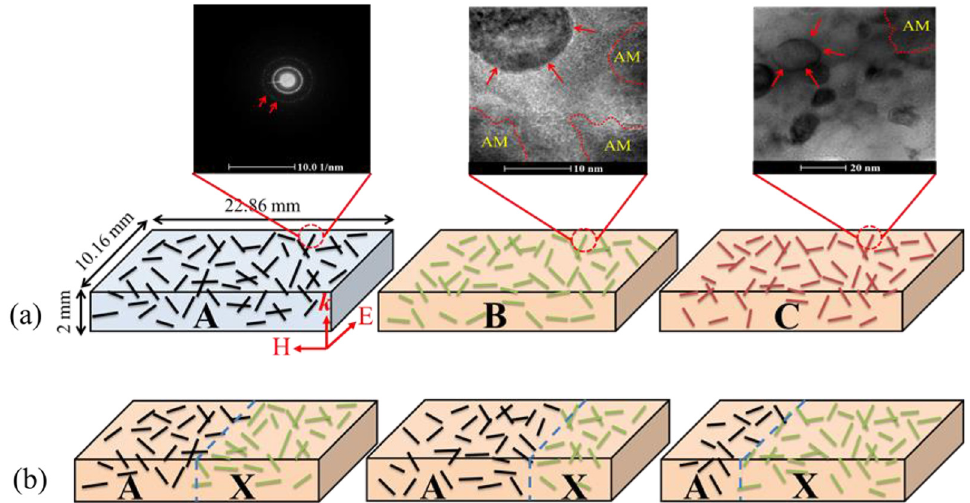
Fig. 1. Randomly dispersed short-cut microwire composites. (a) Composites incorporating the same type of wire, as-cast A, 30 mA- annealed B or 40 mA-annealed C with a total wire amount of 0.053 vol. %. The insets are the SAED pattern for the as-cast wire A, HRTEM images of 30mA-annealed wire B and 40 mA-annealed wire C, where “ AM ” corresponds to the amorphous phases; (b) Composites combining the as-cast A and annealed wires X (where X corresponds to B or C annealed wires) in separated regions and different proportions. The dotted line represents the vertical interface formed between the two different